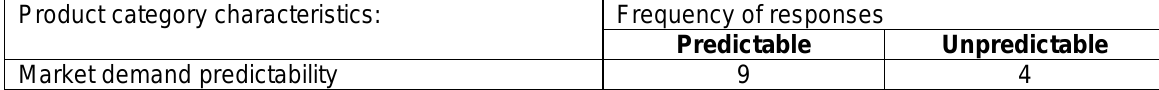
Table 2: Organisations' market demand predictability ( n = 13) Product category characteristics: